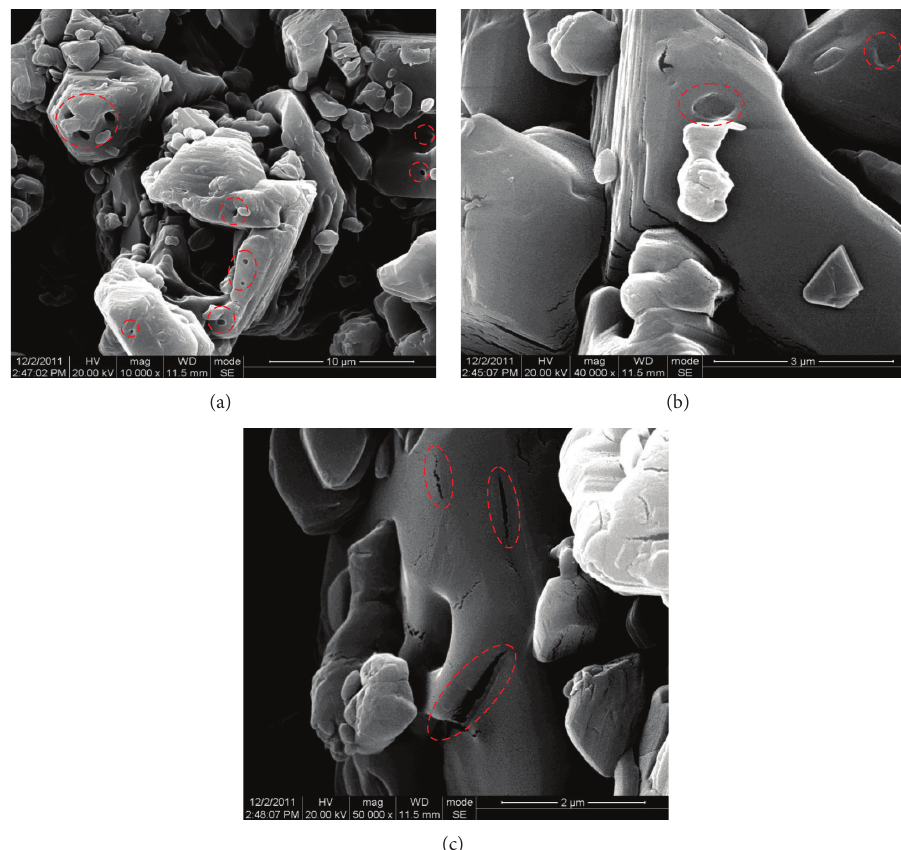
Figure 1: SEM of TATB explosives with different defects: (a) spherical pores, (b) craters, and (c) cracks.